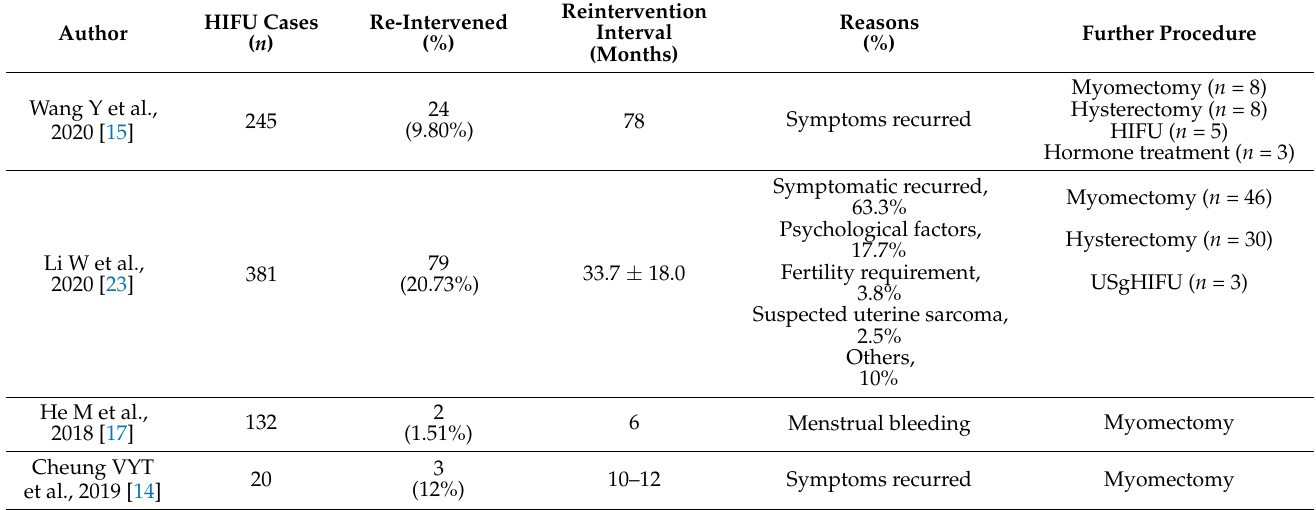
Table 7. Reintervention rates, reasons for reintervention and further